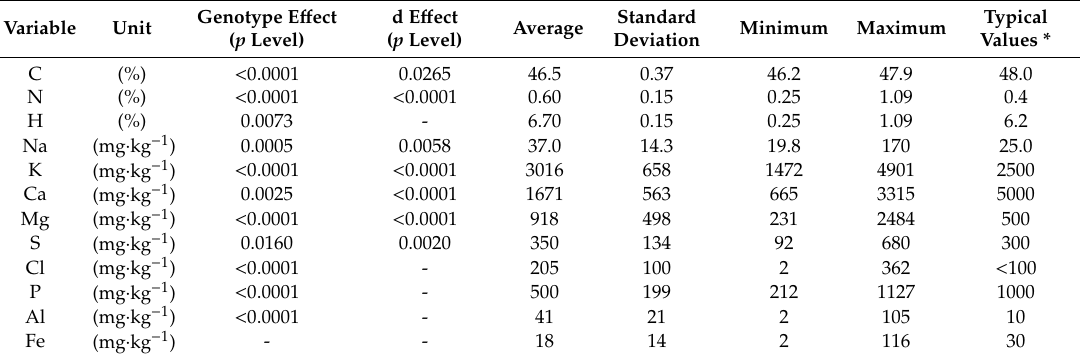
Table 3. Results of the ANCOVA and descriptive statistics for the element concentrations determined.